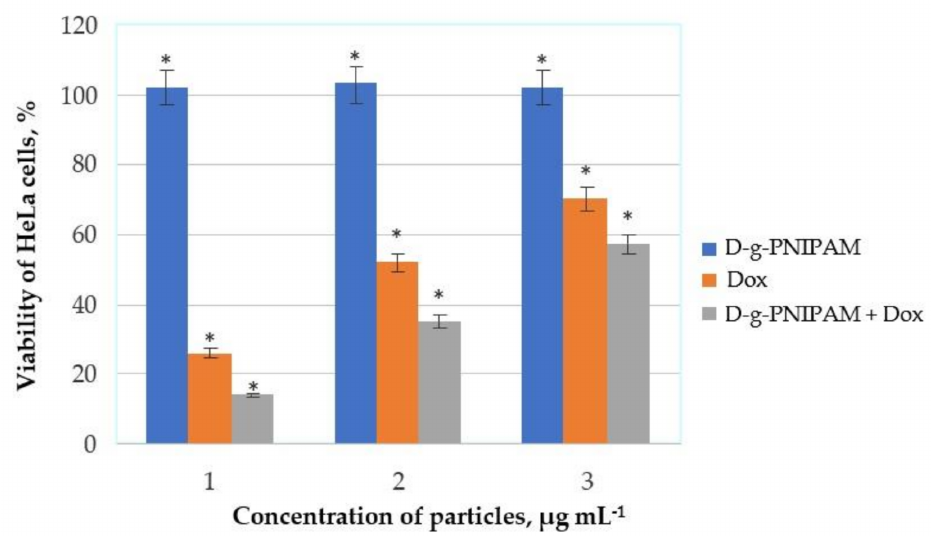
Figure 4. MTT assay results on HeLa cells after 24 h of incubation with D-g-PNIPAM, Dox, and D-g-PNIPAM + Dox particles at different concentrations: 125, 5 and, 125 + 5 µ g mL − 1 (1); 62.5, 2.5, and 62.5 + 2.5 µ g mL − 1 (2); 25, 1, and 25 + 1 µ g mL − 1 (3). Data are given relative to the untreated control samples (* p <